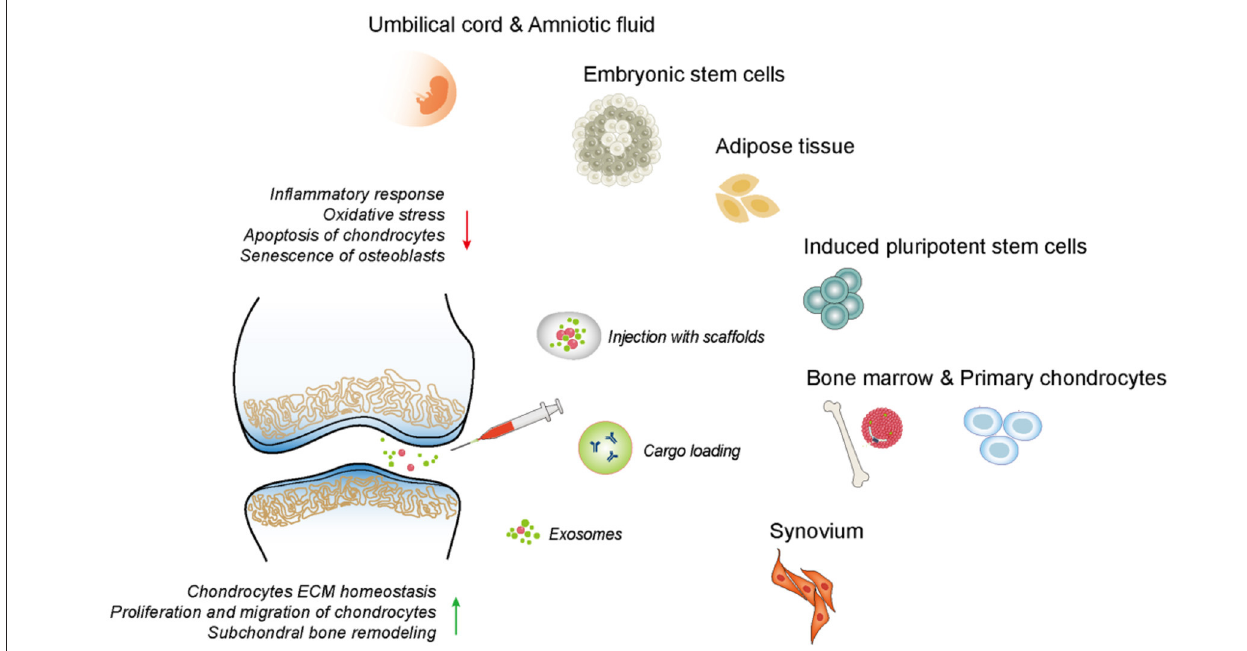
FIGURE 4 | The therapeutic effects of exosomes derived from different tissues on OA. The exosomes could mediate intercellular communication and regulate diverse cell phenotype including inflammatory response, ECM synthesis, chondrocytes proliferation, migration, apoptosis,